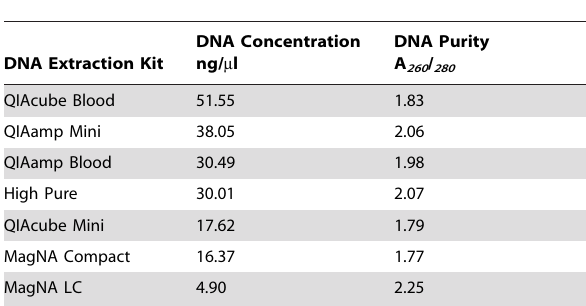
Table 1. Average concentration and purity of DNA